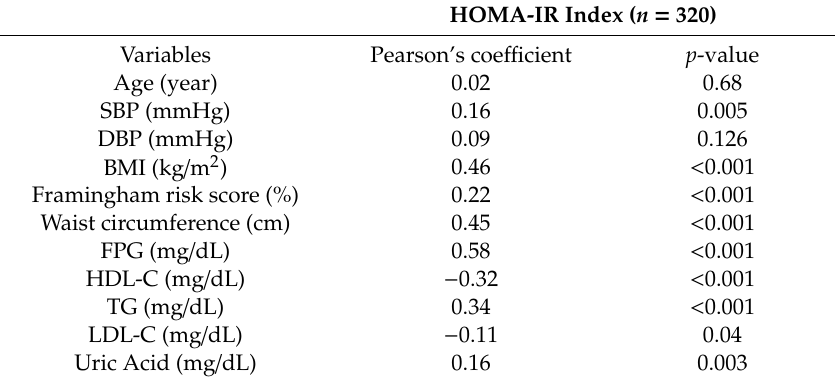
Table 2. Pearson correlation coe ffi cient of the HOMA-IR levels with the cardiovascular disease risk factors.